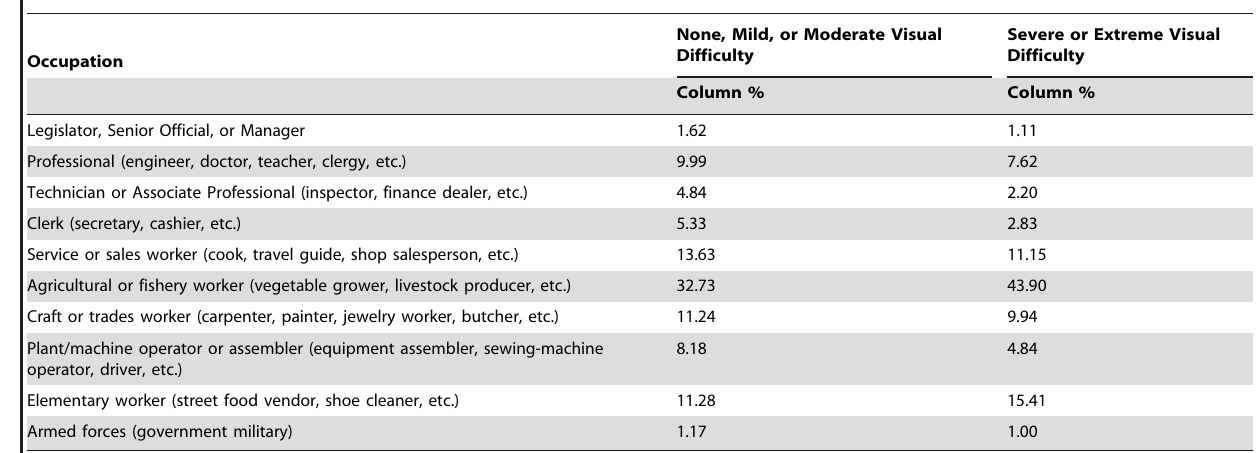
Table 4. Type of occupation by visual difficulty